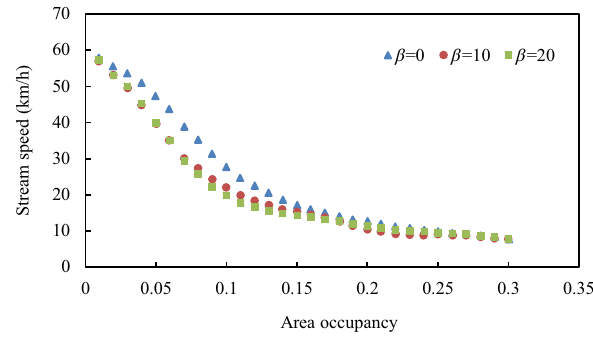
Fig. 14 Relationship between area occupancy and flow for different values of D x (average) and only car scenario using the PP-CA